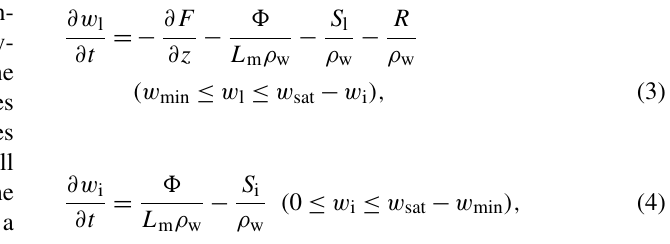
end of the time step (Fig.